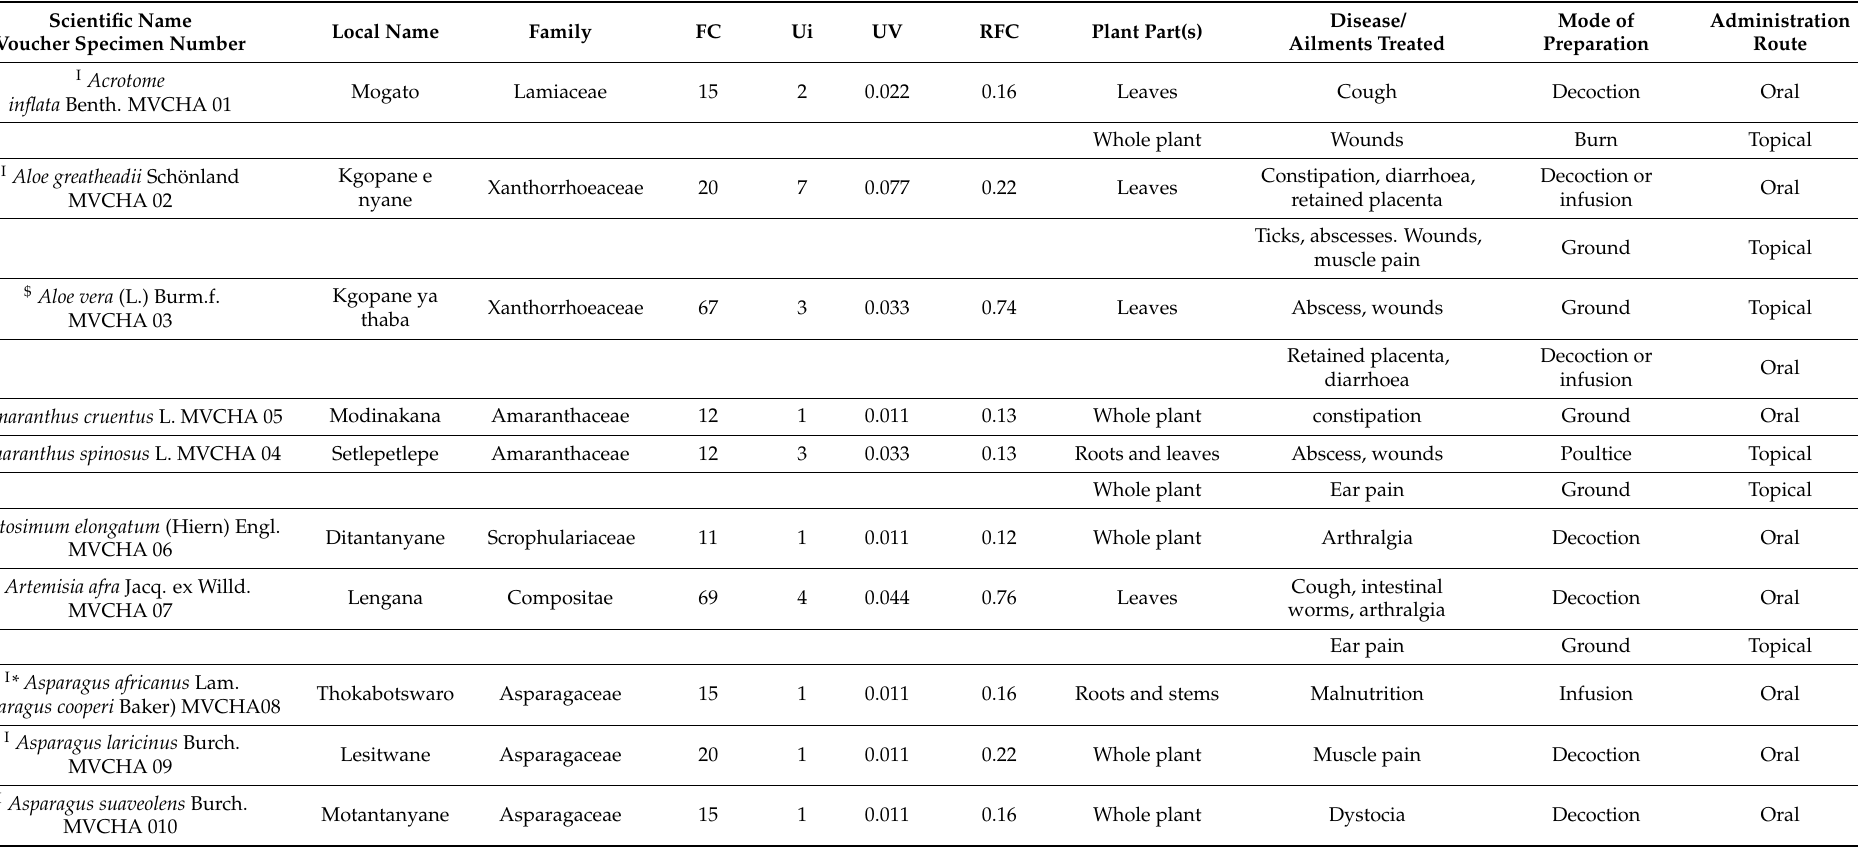
Table 3. Medicinal plants used to treat various cattle ailments in the Ramotshere Moiloa local municipality (FC = number of participants who reported using a certain species, UV = use-value, Ui = the number of uses stated by each participant for a specific species, RFC = relative frequency of citation, * = plants possibly identified for the first time used for treating cattle diseases as no records were found). The nomenclature of all the collected plant species has been updated using The World Flora Online (http://www.worldfloraonline.org/, accessed on 22 March 2022). I Indigenous and $ introduced/cultivated/naturalised plants were based on Plants of Southern Africa (POSA) (http://posa.sanbi.org/, accessed on 16 June 2022) and the African Plant Database (https://africanplantdatabase.ch/, accessed on 22 June